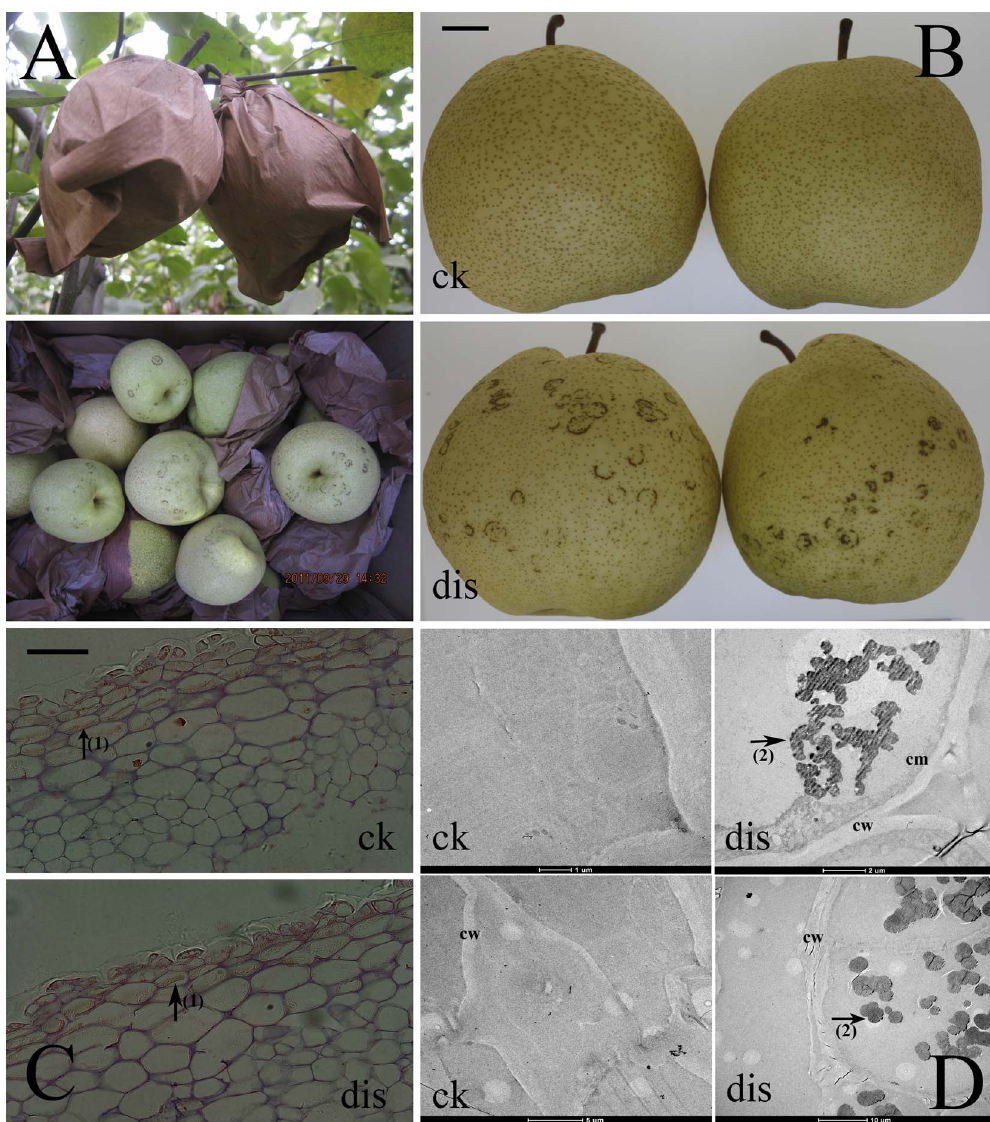
Figure 1. Surface brown spots disease (SBS, dis) in ‘‘Dangshansuli’’ pear fruit. (A) The SBS pears were collected from the orchards at which the fruit was bagged. (B) SBS Symptoms. The dark brown spot is confined to the peel of the fruit, and other parts of fruit, such as the flesh and core, are normal. (C) Paraffin sections observed by optical microscopy. (D) Transmission electron microscope (TEM). Arrow1: lignin; arrow 2: polyphenolic bodies. Bar: 2